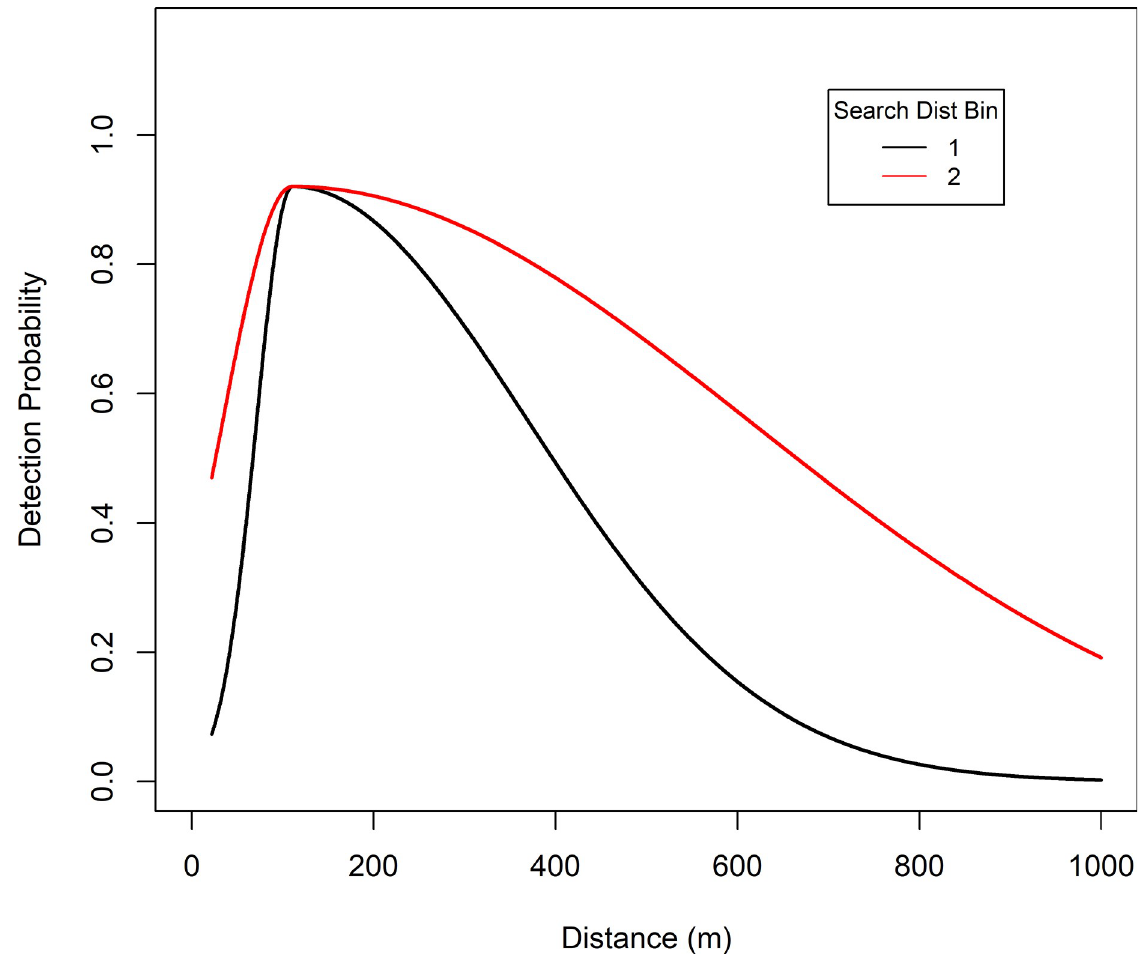
Fig 5. Estimated detection of brown bears in Game Management Unit 9D and 10, Southwest Alaska, by binned search distance, from a spring 2002 distance sampling survey. Bins (Bin2SD1000) were coded as: Bin 1 = 0 (search distance was 1000 m or less), Bin 2 = 1 (search distance greater than 1000